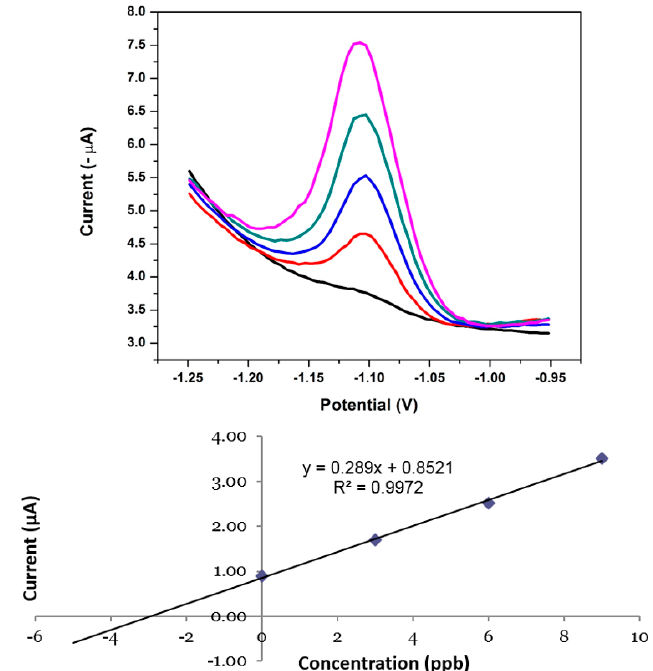
Figure 18. SWAdSV and corresponding standard addition calibration plot of the individual analysis of Ni 2+ in the presence of Co 2+ and Zn 2+ obtained at a NGr-DMG-GCE in real tap water samples.